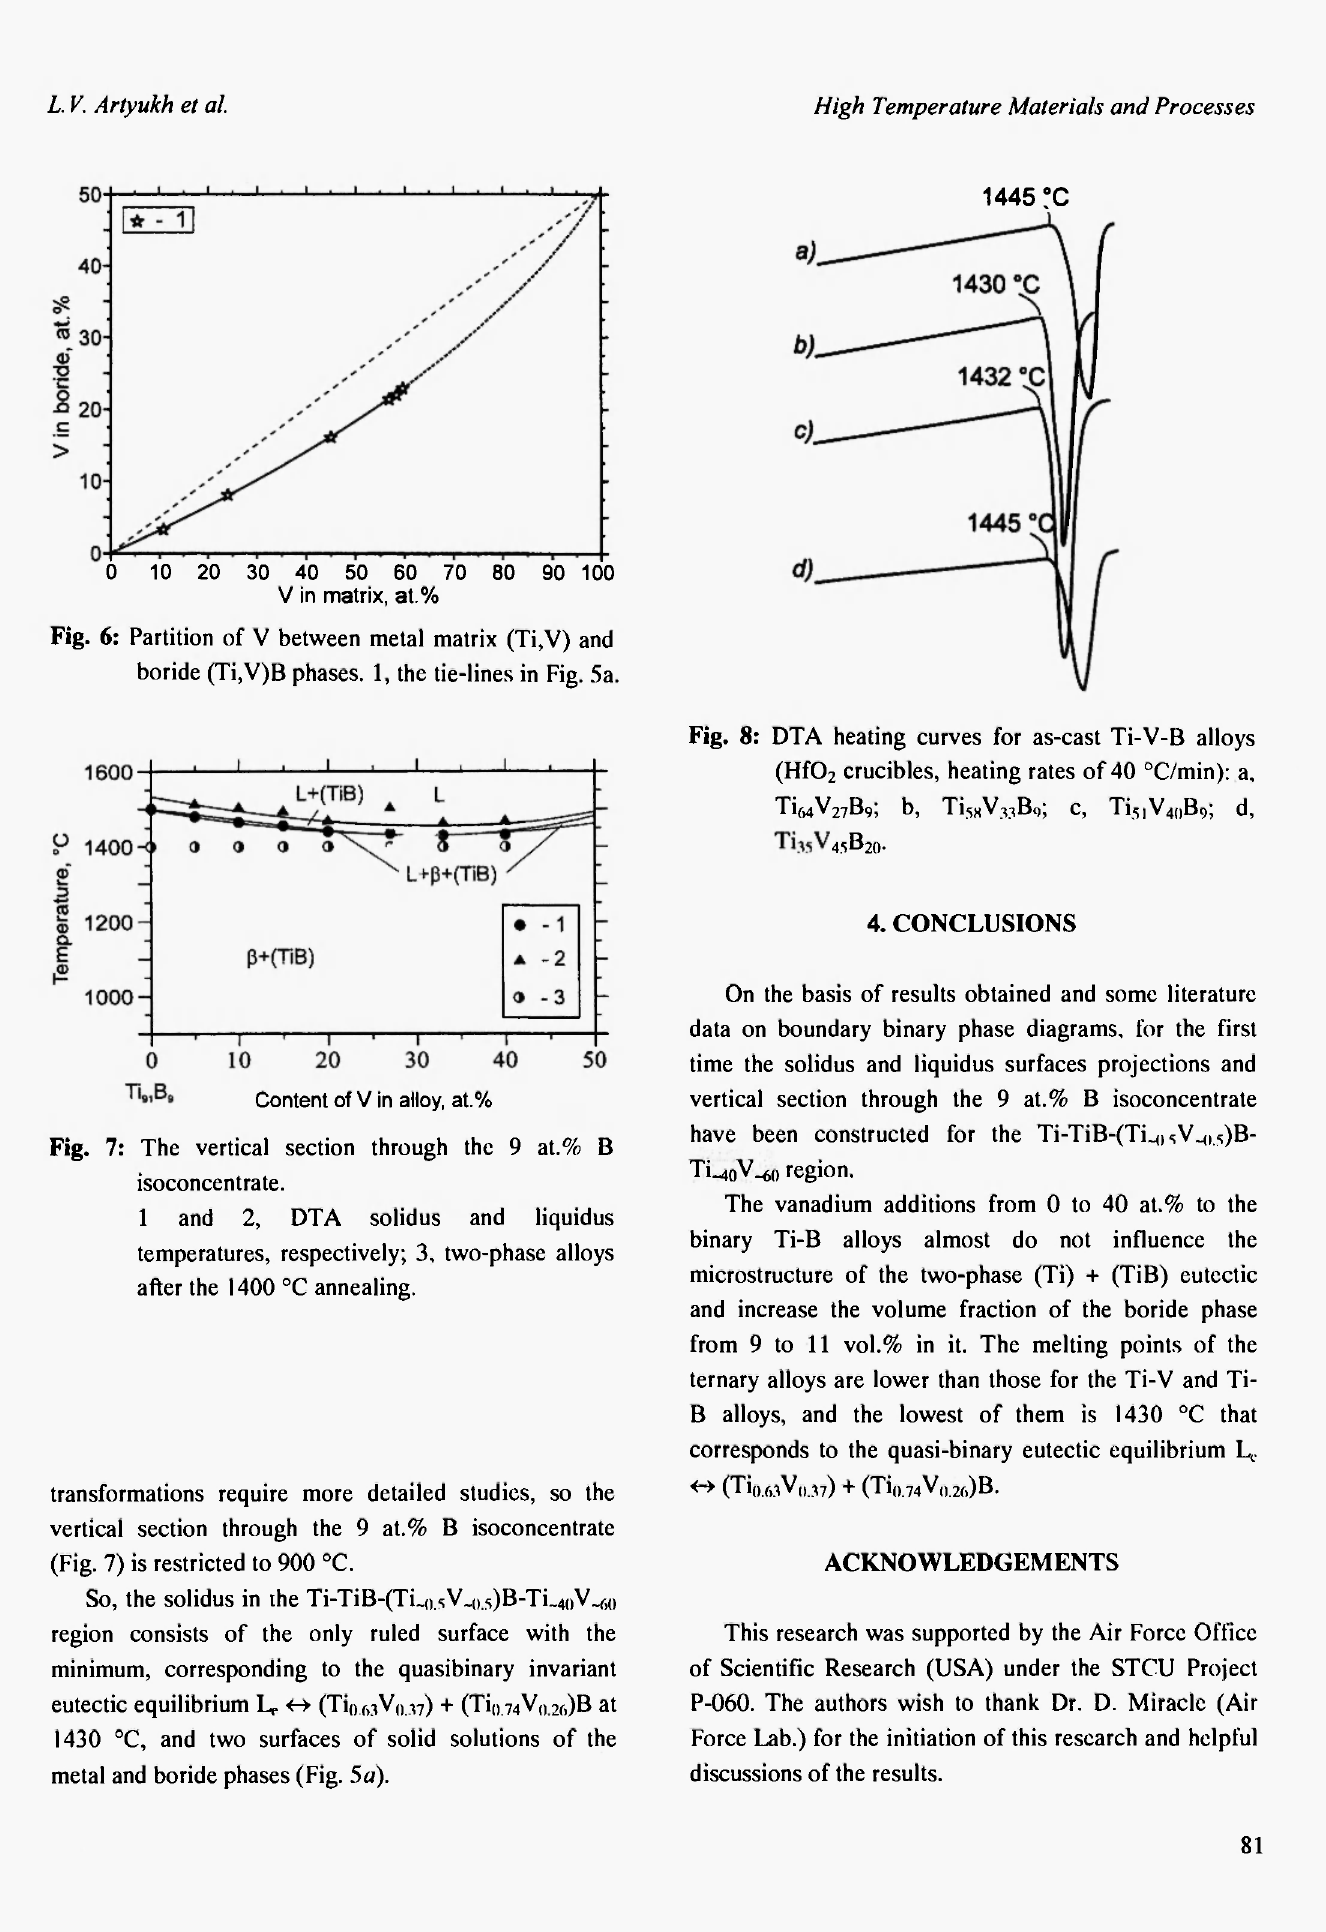
Fig. 8: DTA heating curves for as-cast Ti-V-B alloys (Hf0 2 crucibles, heating rates of 40 °C/min): a, Ti M V 2 7B 9